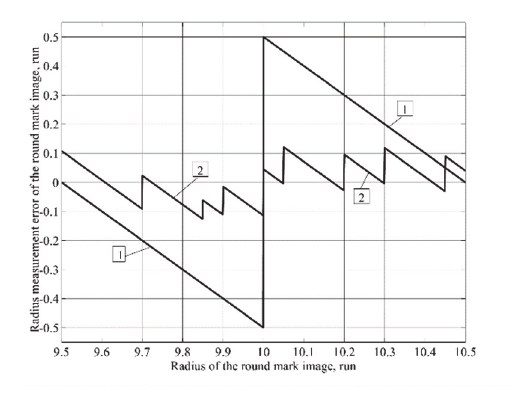
Fig. 2. The radius measurement error of the round mark image. In Fig. 2, a broken line 1 corresponds to the radius measurement error  r cl of the round mark image by the line counting method, and a broken line 2 corresponds to the radius measurement error  r cp of the round mark image by the pixel counting method. The radius measurement error of the round mark image by the method of line counting varies between limiting values +0.5 run and –0.5 run. The radius measurement error of the round mark image by the method of pixel counting varies between the limiting values +0.1211 run and – 0.1259